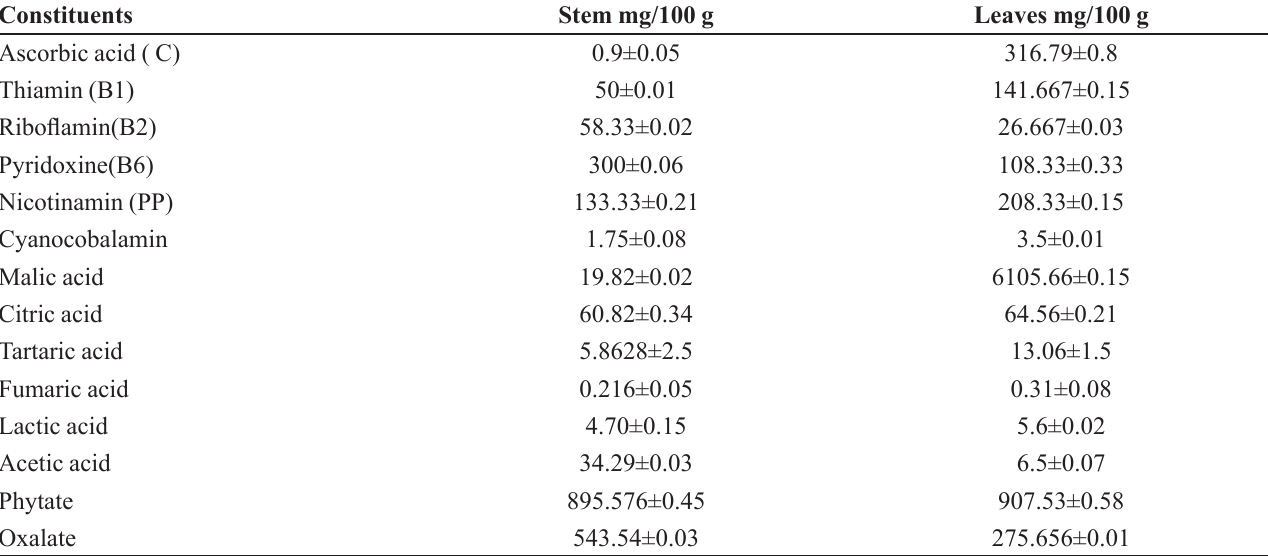
Values are means± standard deviation of three determinations